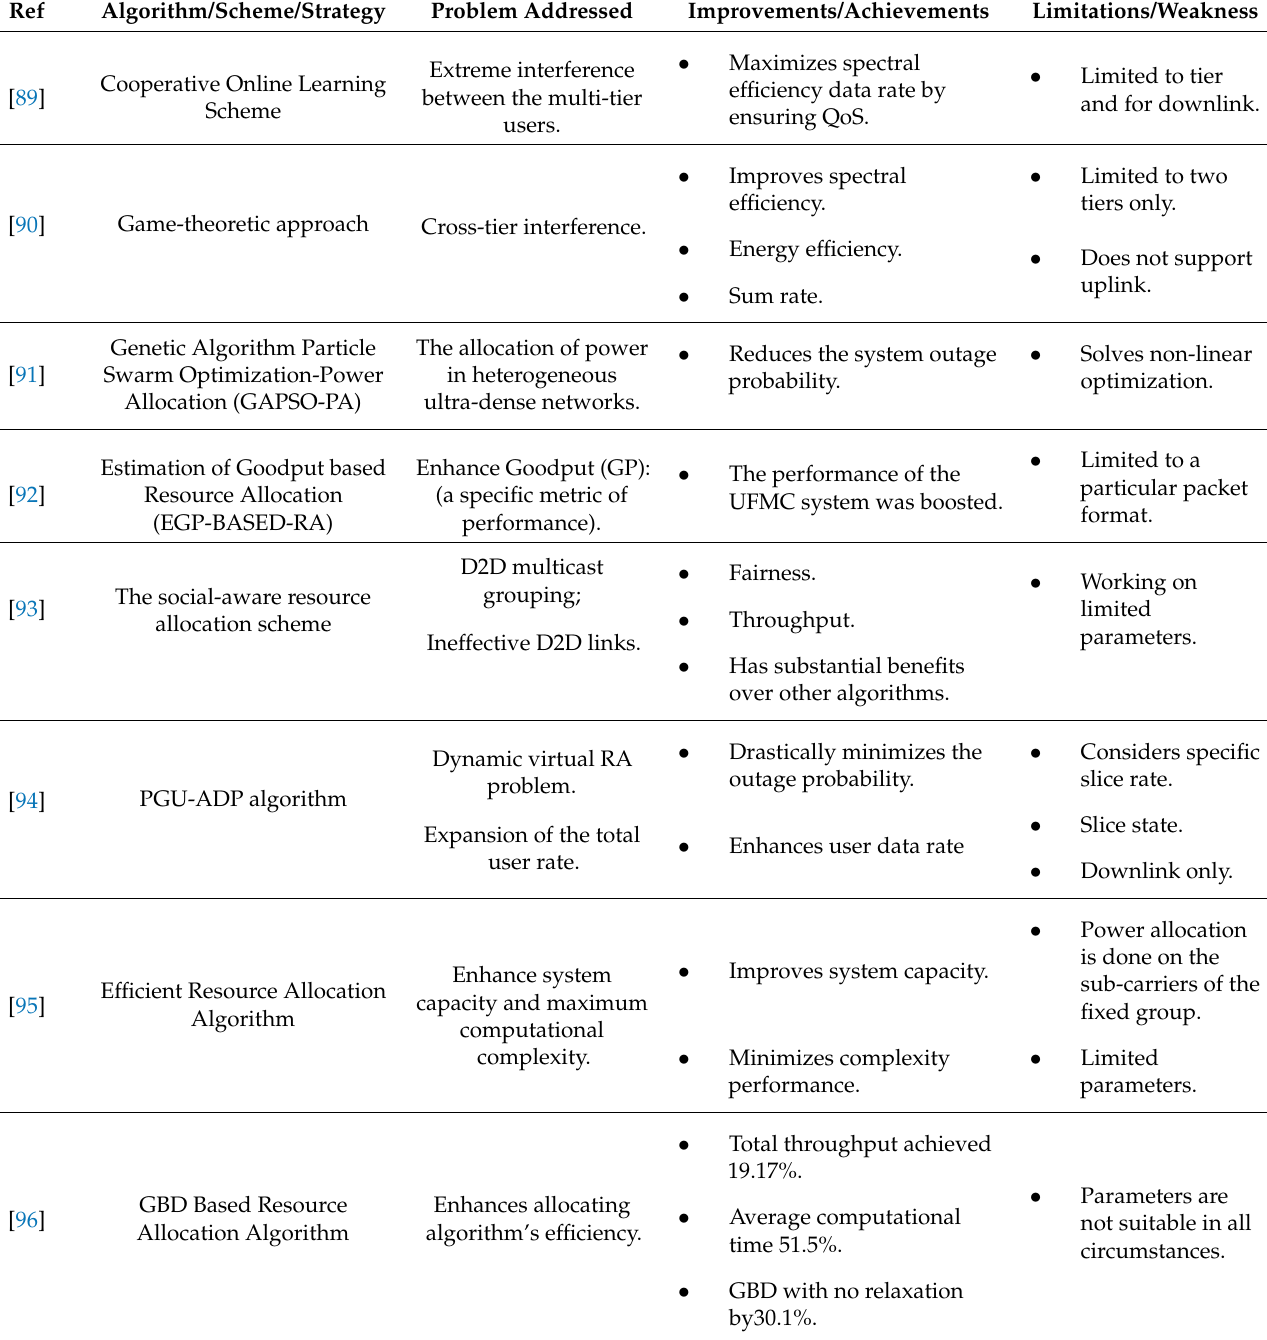
Table 4. Characteristics of selected resource allocation techniques in